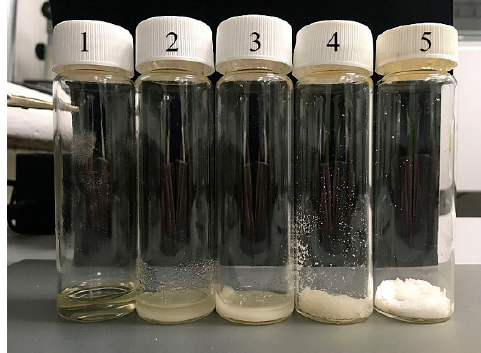
Figure 3. Photos of NMMO–IPA mixtures at room temperature with NMMO content: (1) 50; (2) 60; (3) 70; (4) 80; and (5) 90 (mass %).